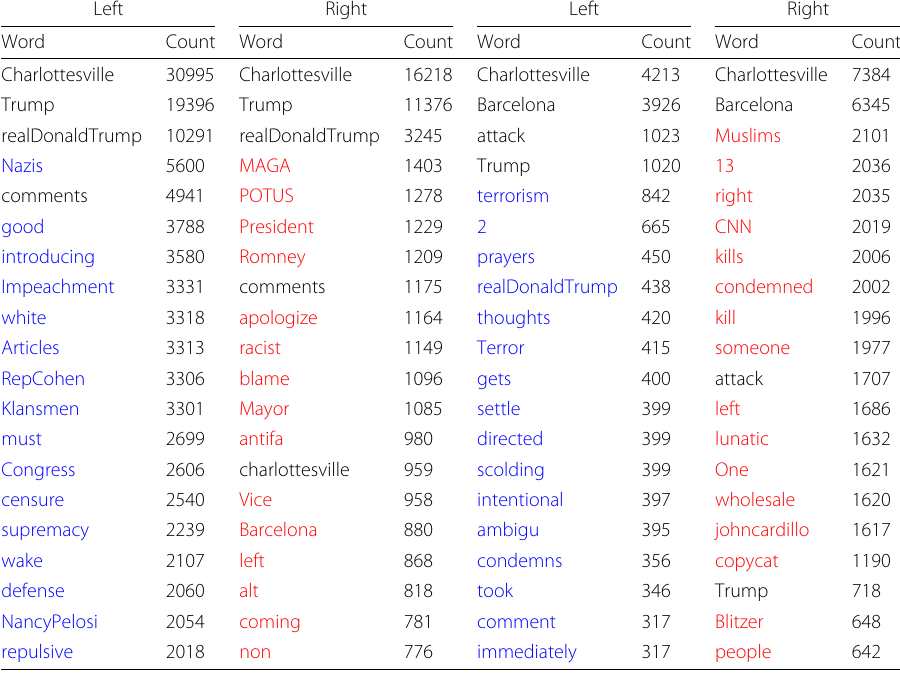
Table 5 The 20 most common words (excluding words that correspond to handles of non-verified accounts) from the subset of tweets that include (left set of columns) the word ‘Trump’ and (right set of columns) the word